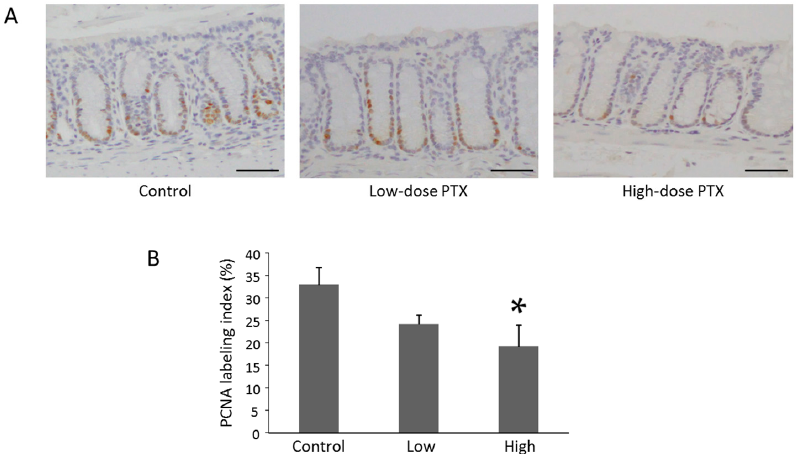
Figure 2. Effects of PTX on cellular proliferation of colon epithelium in the experimental mice. ( A ) Assessment of the normal crypts in the colon of AOM-treated db / db mice using antibody for proliferating cell nuclear antigen (PCNA). Sections of the colon from each group were stained immunohistochemically with anti-PCNA antibody, as described in the Materials and Methods section. Representative photomicrographs from each group are shown. Scale bars, 200 µm; ( B ) Evaluation of PCNA labeling index in the normal crypts in the colon of the experimental mice. Each column represents the mean ± SD ( n = 6 for each group). * p < 0.05 vs. PTX-untreated control group.